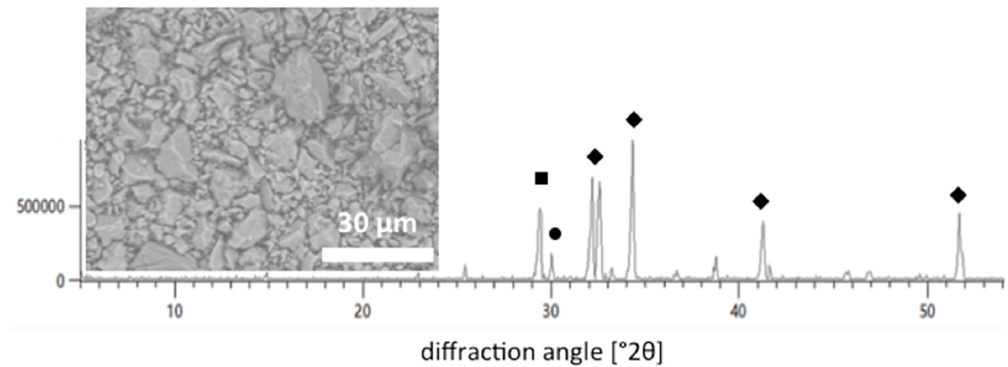
Figure 1. X-ray diffractogram and SEM (inset) of the material (White Portland Cement) used as a calcium and silicon source in the modification of a base coat nail polish formulation. ( (cid:4) ) CC = calcite; ( • ) C 2 S = dicalcium silicate; ( (cid:7) ) C 3 S = tricalcium